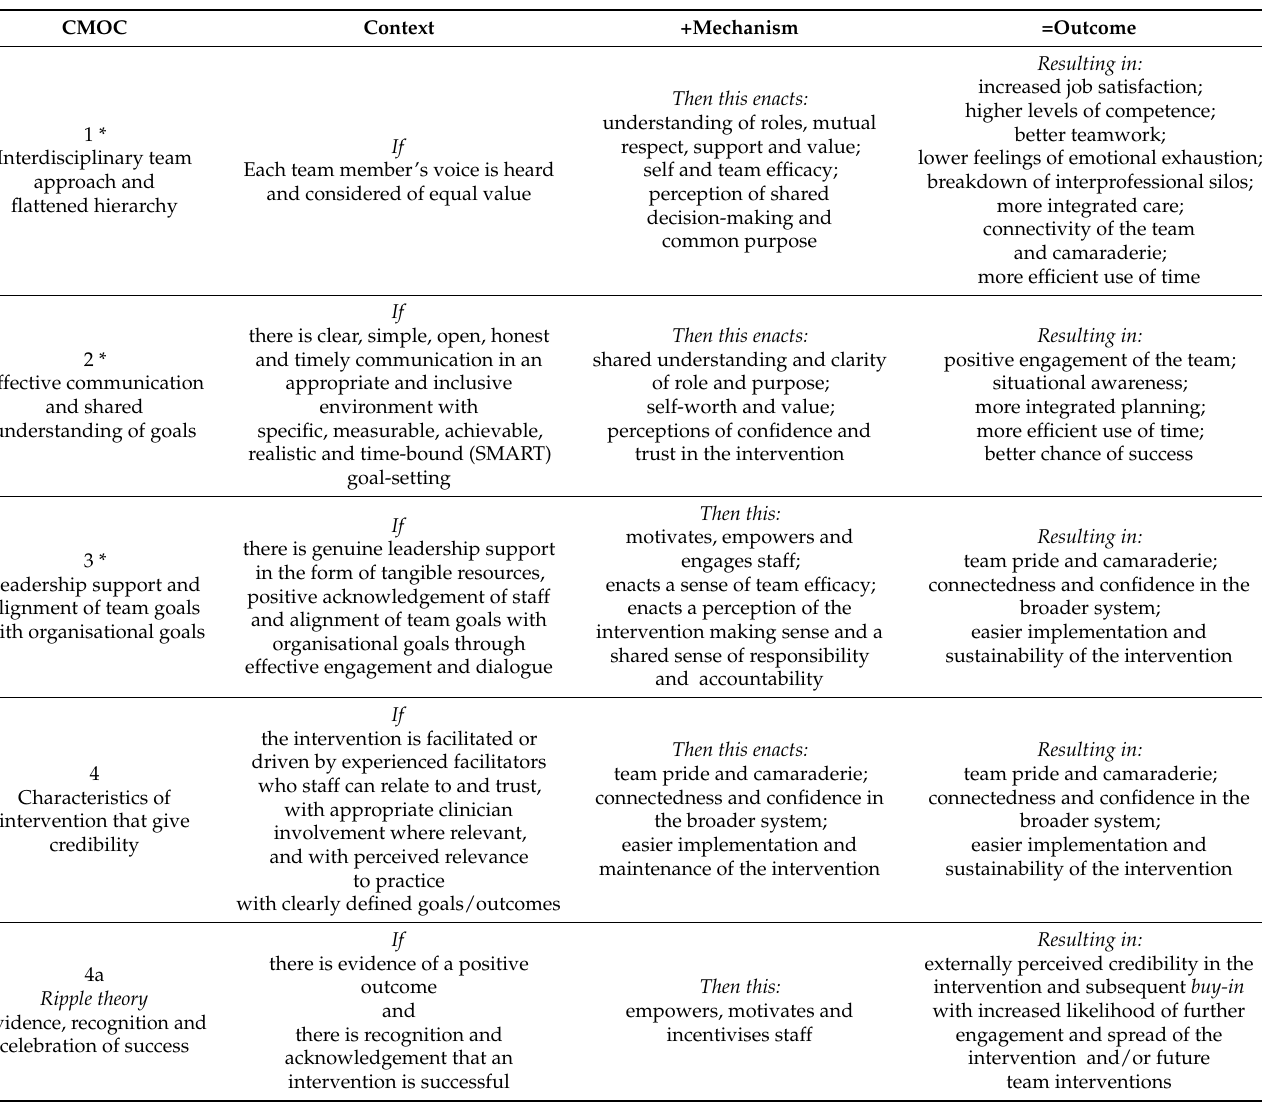
Table 2. Initial programme theories